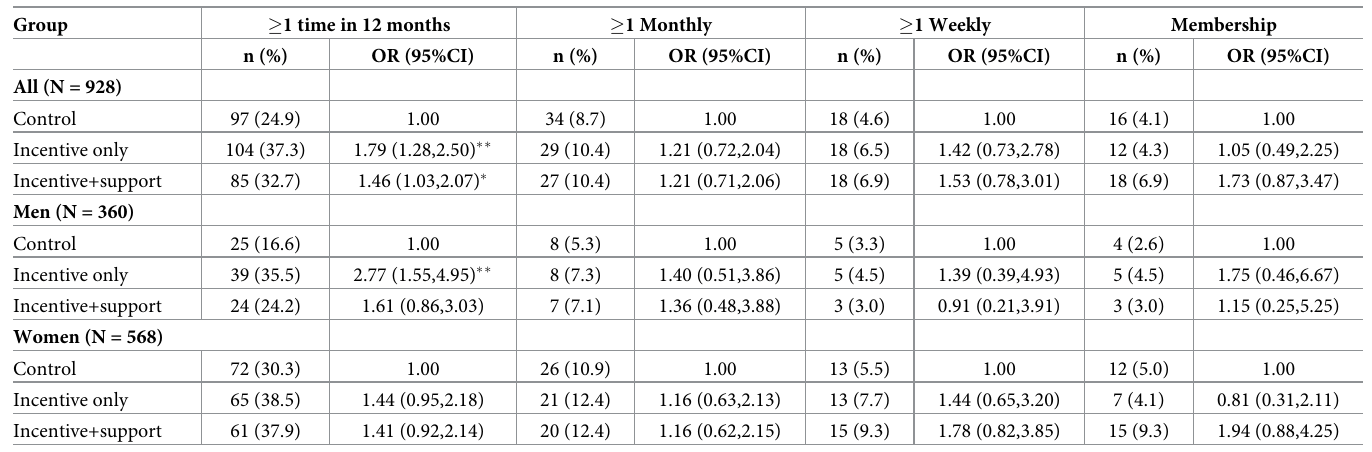
Table 2. PARC attendance and PARC membership after 12 months.